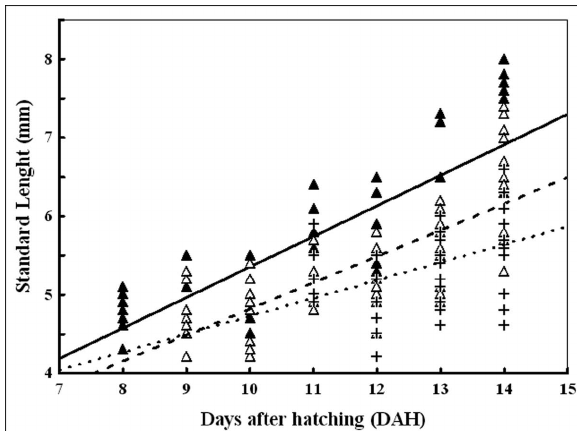
Fig . 2. – Changes in standard length (SL) of fed and starved larvae of S. senegalensis . Each symbol represents results for an individual larva. Closed triangles represent fed fish (y = 0.39x + 0.94, r 2 = 0.64); opened triangles represent short starvation fish (y = 0.33x + 0.98, r 2 = 0.56), and cross symbols represent long starvation fish (y = 0.23x + 1.94, r 2 = 0.17). The thick line is the regression line for fed fish; the broken line is the regression line for short starvation fish and the dotted line is the regression line for long starvation fish.